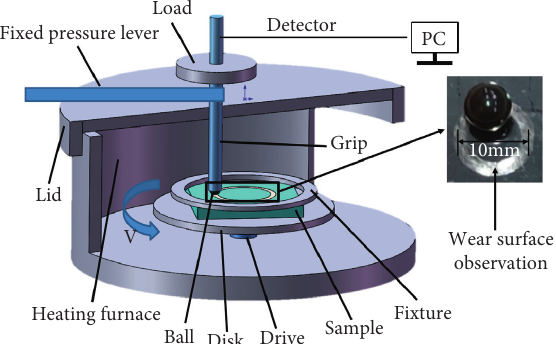
Figure 2: A sketch showing the experimental